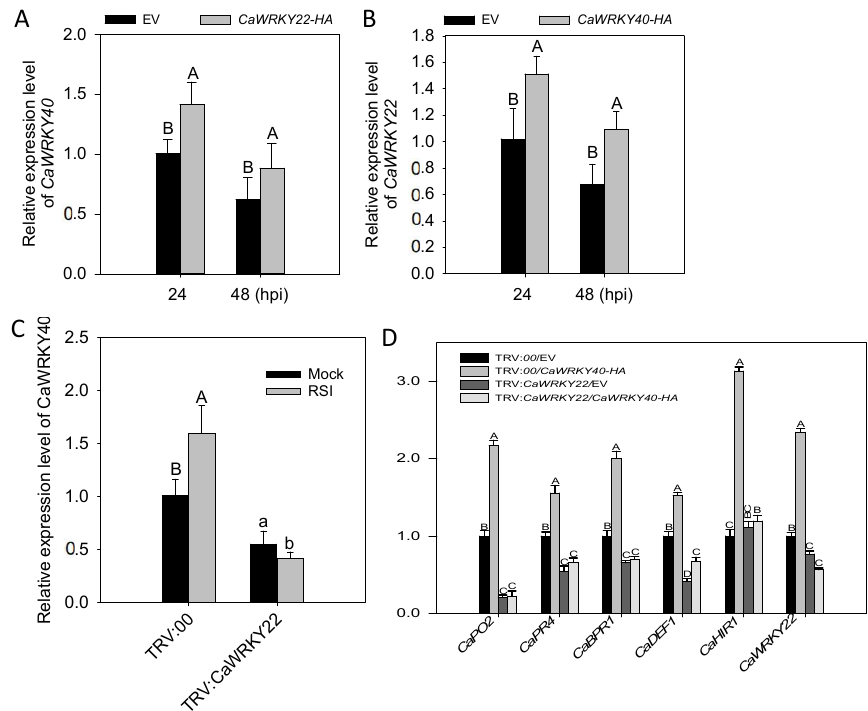
Figure 7. The inter-relationship between CaWRKY22 and CaWRKY40 . ( A ) Transcriptional expression of CaWRKY40 in pepper leaves transiently overexpressing CaWRKY22 at 24 and 48 hpi. The expression level of pepper leaves transiently overexpressing the empty vector was set to “1”; ( B ) transcriptional expression of CaWRKY22 in pepper leaves transiently overexpressing CaWRKY40 at 24 and 48 hpi. The expression level of pepper leaves transiently overexpressing the empty vector was set to “1”; ( C ) qRT-PCR analysis of CaWRKY40 expression levels in CaWRKY22 -silenced and control pepper plants. The expression level of mock treated unsilenced pepper leaves was set to “1”; ( D ) qRT-PCR analysis of the transcriptional levels of defense-related marker genes in CaWRKY22 -silenced and control pepper plants transiently overexpressing 35S: CaWRKY40-HA and 35S:00. ( A – D ) Data represents the means ± SD from four biological replicates. The relative expression level of mock treated unsilenced plants was set to “1”. Error bars indicated the standard error. Different letters indicate significant differences between means, as determined by Fisher’s protected LSD test: uppercase letters, p < 0.01; lower case letters, p < 0.05.